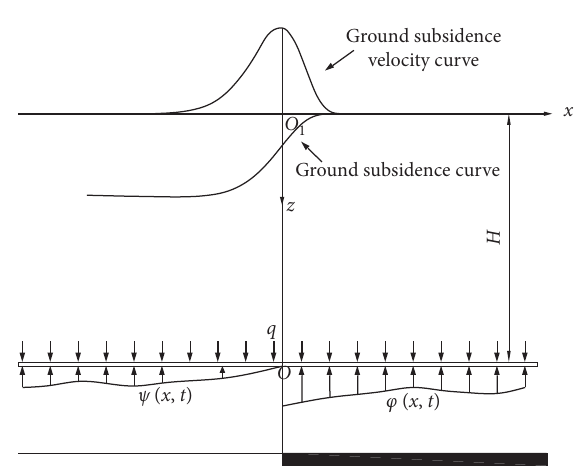
Figure 2: Construction of the coordinate